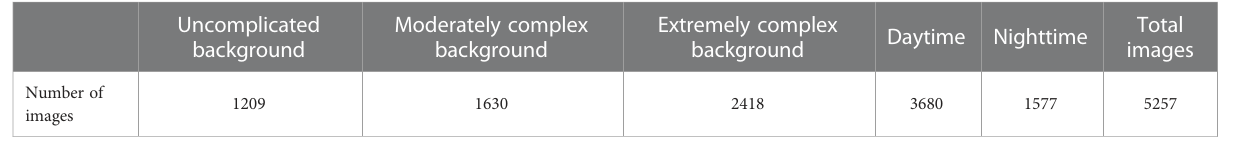
TABLE 1 Details of the pear image